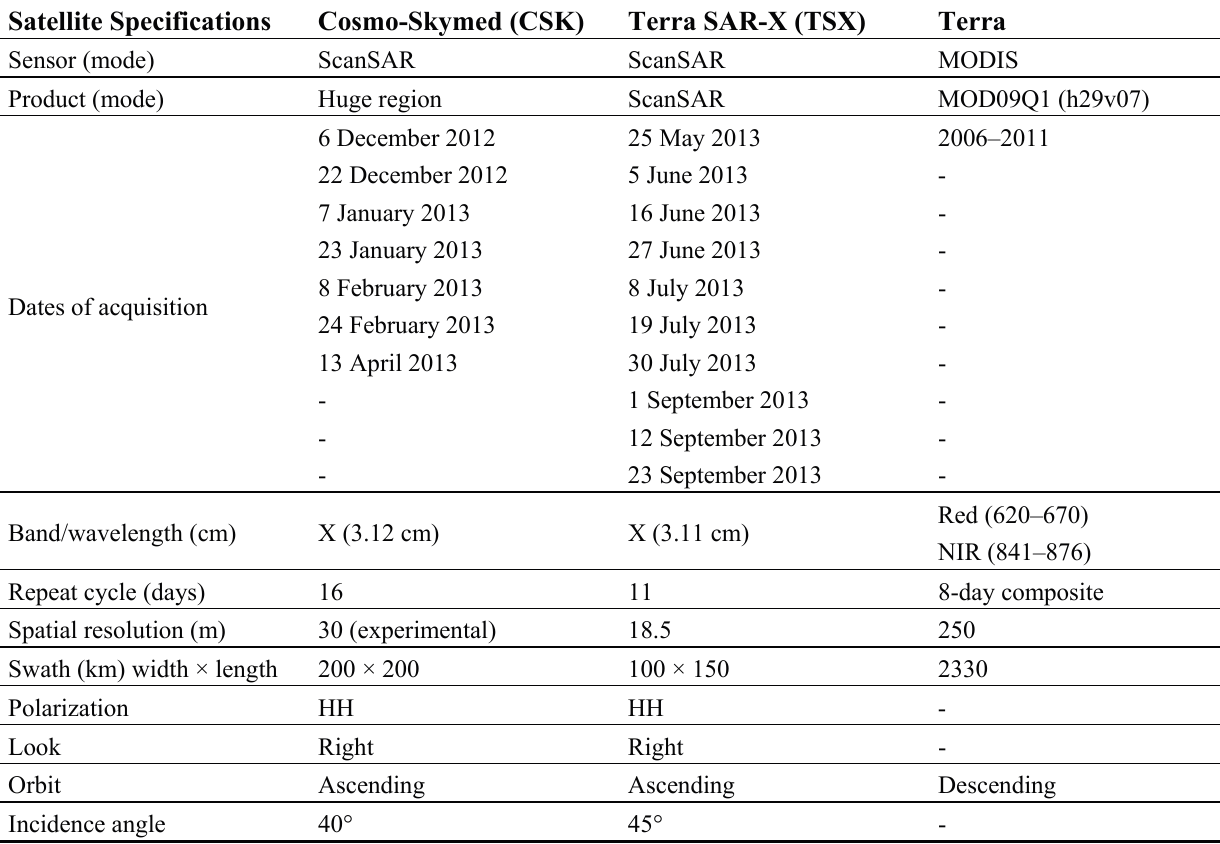
Table 1. Characteristics of the series of satellite images acquired for rice